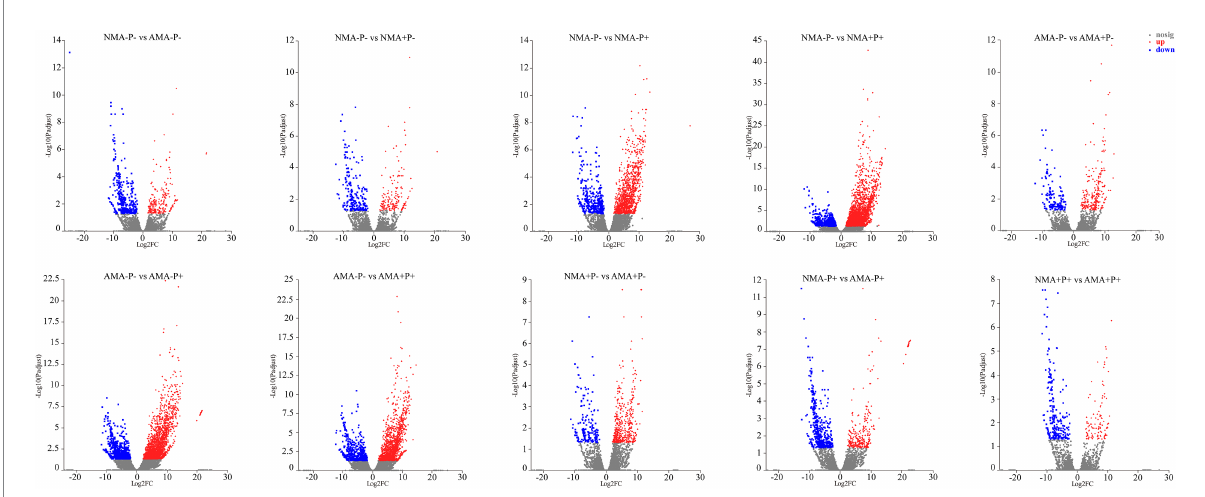
FIGURE 5 Analysis of DEGs in alfalfa in the comparisons NMA − P − vs. AMA − P − , NMA − P − vs. NMA+P − , NMA − P − vs. NMA − P+, NMA − P − vs. NMA+P+, AMA −